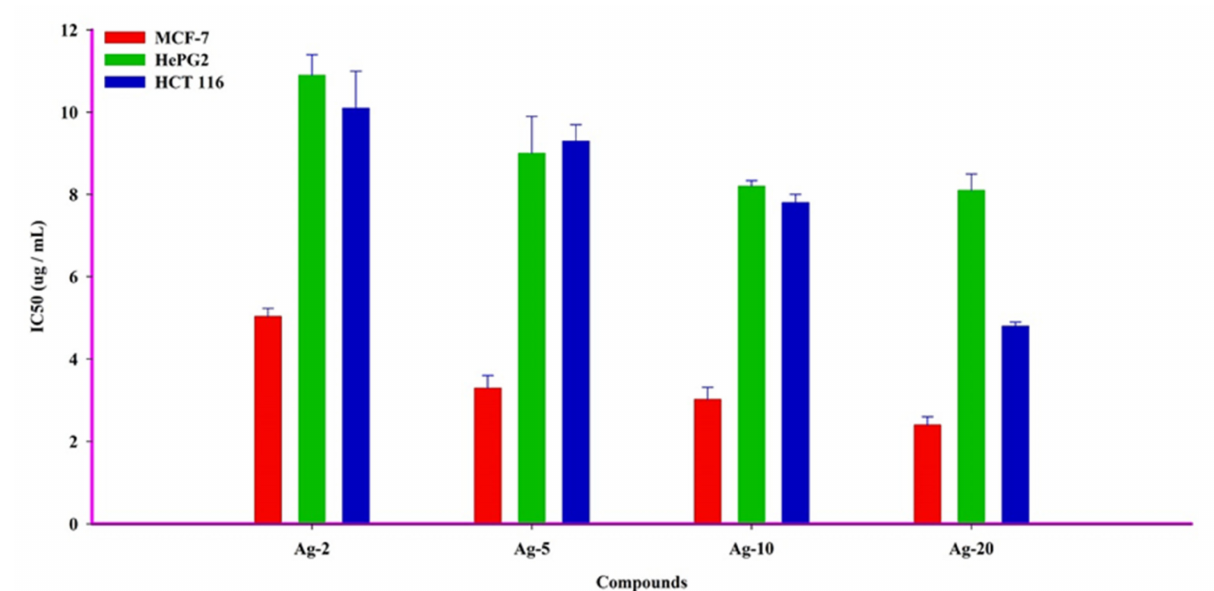
Figure 6. IC 50 values of the prepared samples after treating different human cancer cell lines (MCF-7, HePG2, and HCT 116).